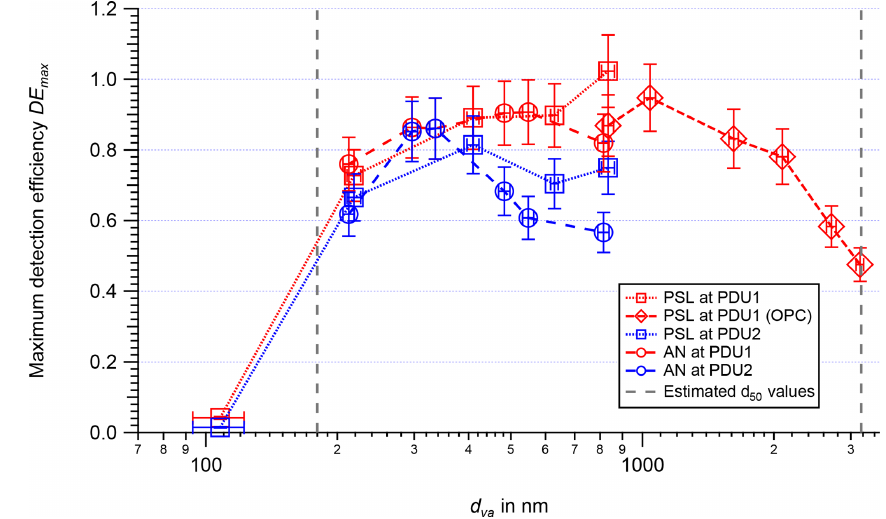
Figure 6. Maximum detection efficiency DE max as a function of particle size d va for PSL (squares) and AN (circles) particles measured at PDU1 (red) and PDU2 (blue). CPC and OPC measurements are as for Fig. 3. The estimated d 50 (50% of the maximum) values of the optical detection are marked by vertical dashed gray lines. The uncertainties in DE max reflect the conservatively estimated value of 10%.